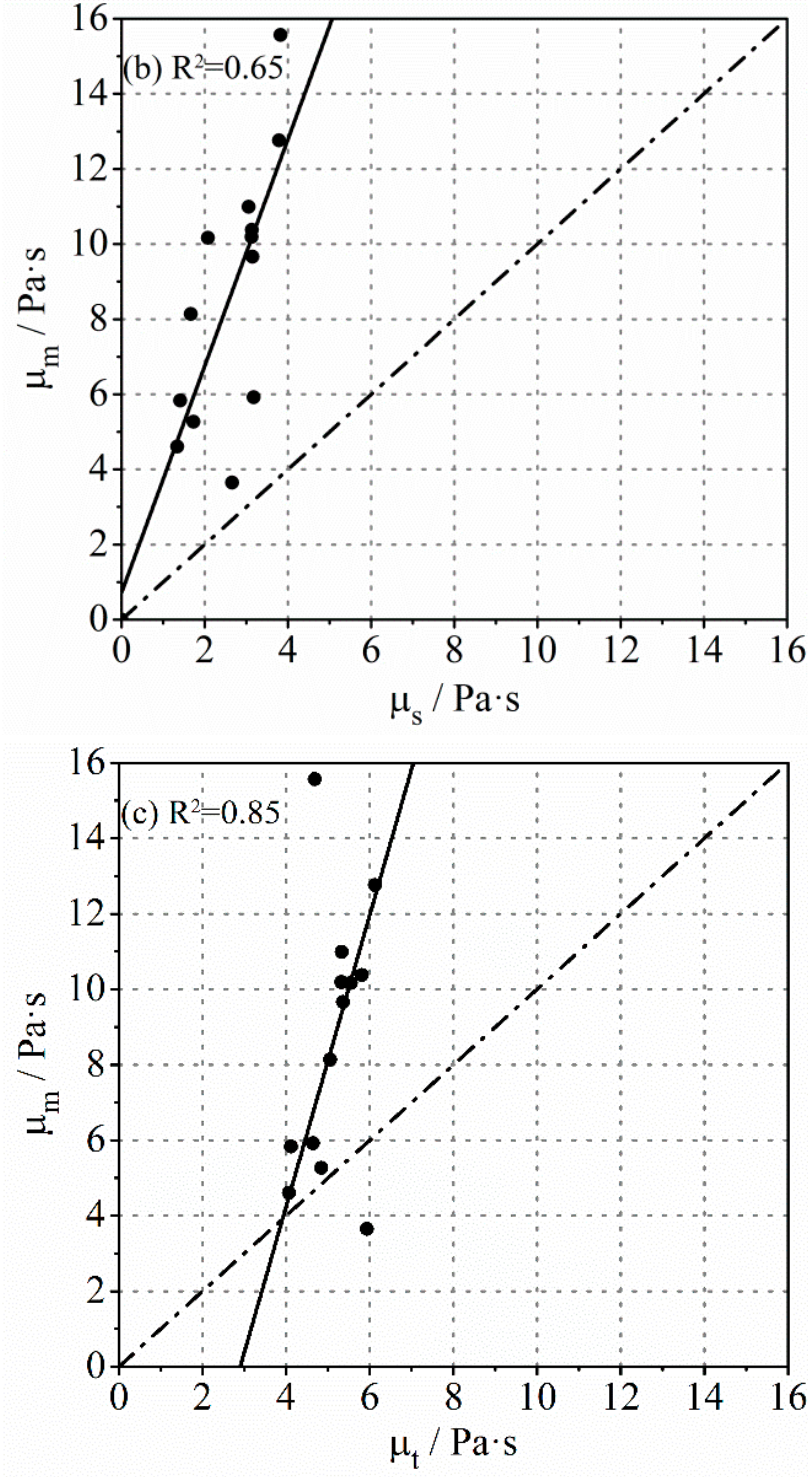
Figure 3. Comparison of the viscosity of the lubrication layer determined by different methods: ( a ) η t and η s ; ( b ) µ m and µ s ; ( c ) µ m and µ t .